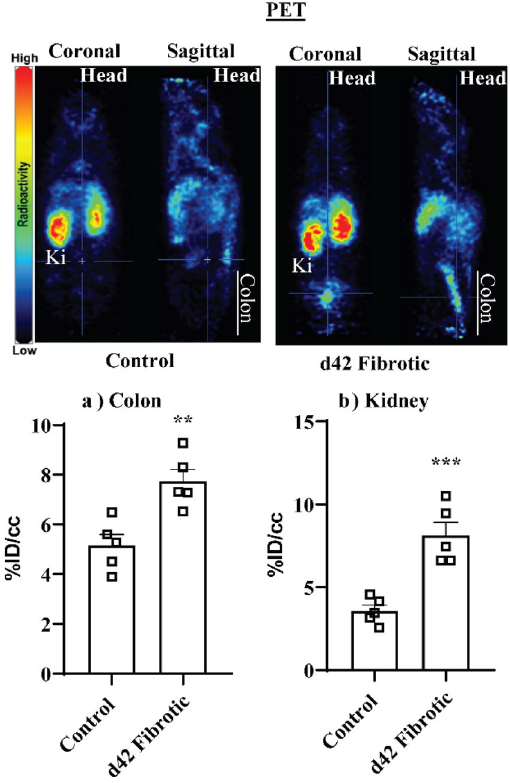
Figure 5. 89 Zr-α-pro-MMP-9 F(ab ′ ) 2 PET detection of ( a ) colonic and ( b ) kidney fibrosis. Volume of interest (VOI) analysis with representative PET image (coronal and sagittal) of control and fibrotic mice. Ki kidney. ** P < 0.01, *** P <